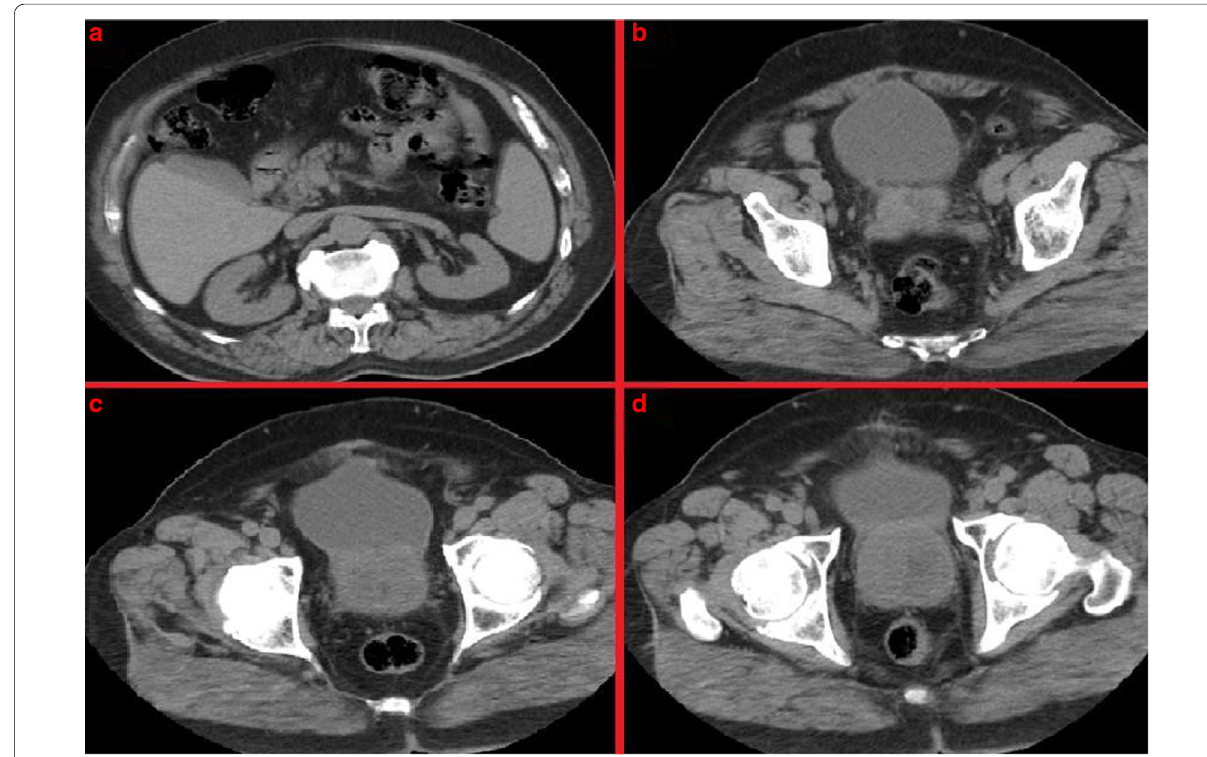
Fig. 3 Postoperative imaging of prostatic lodge and kidney. Imaging of the kidney and the prostate after 5 years from the surgery